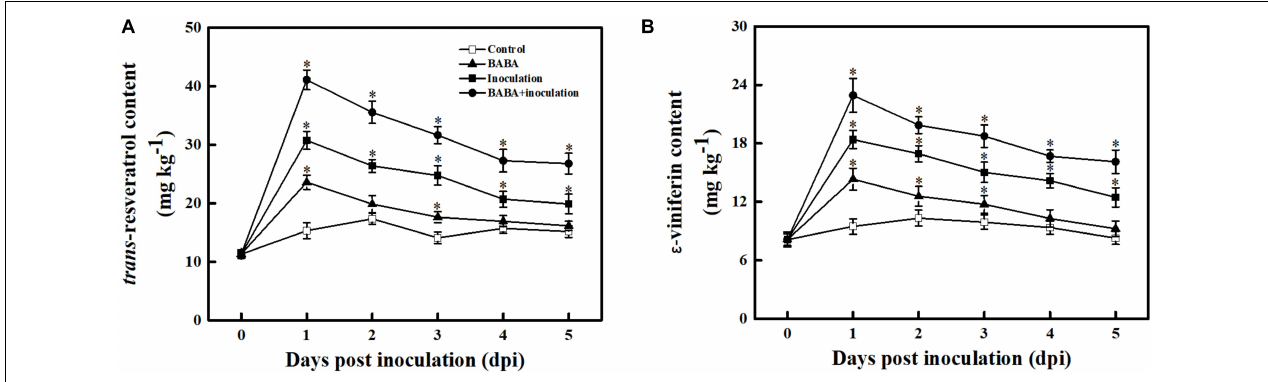
FIGURE 4 | Changes in the amounts of trans -resveratrol (A) and ε -viniferin (B) in grapes after inoculation with B. cinerea at 1-day intervals. Phytoalexin contents are expressed as the mean ± SE. An asterisk represents a significant difference between pathogen- or BABA-treated and untreated grapes ( p = 0.05).